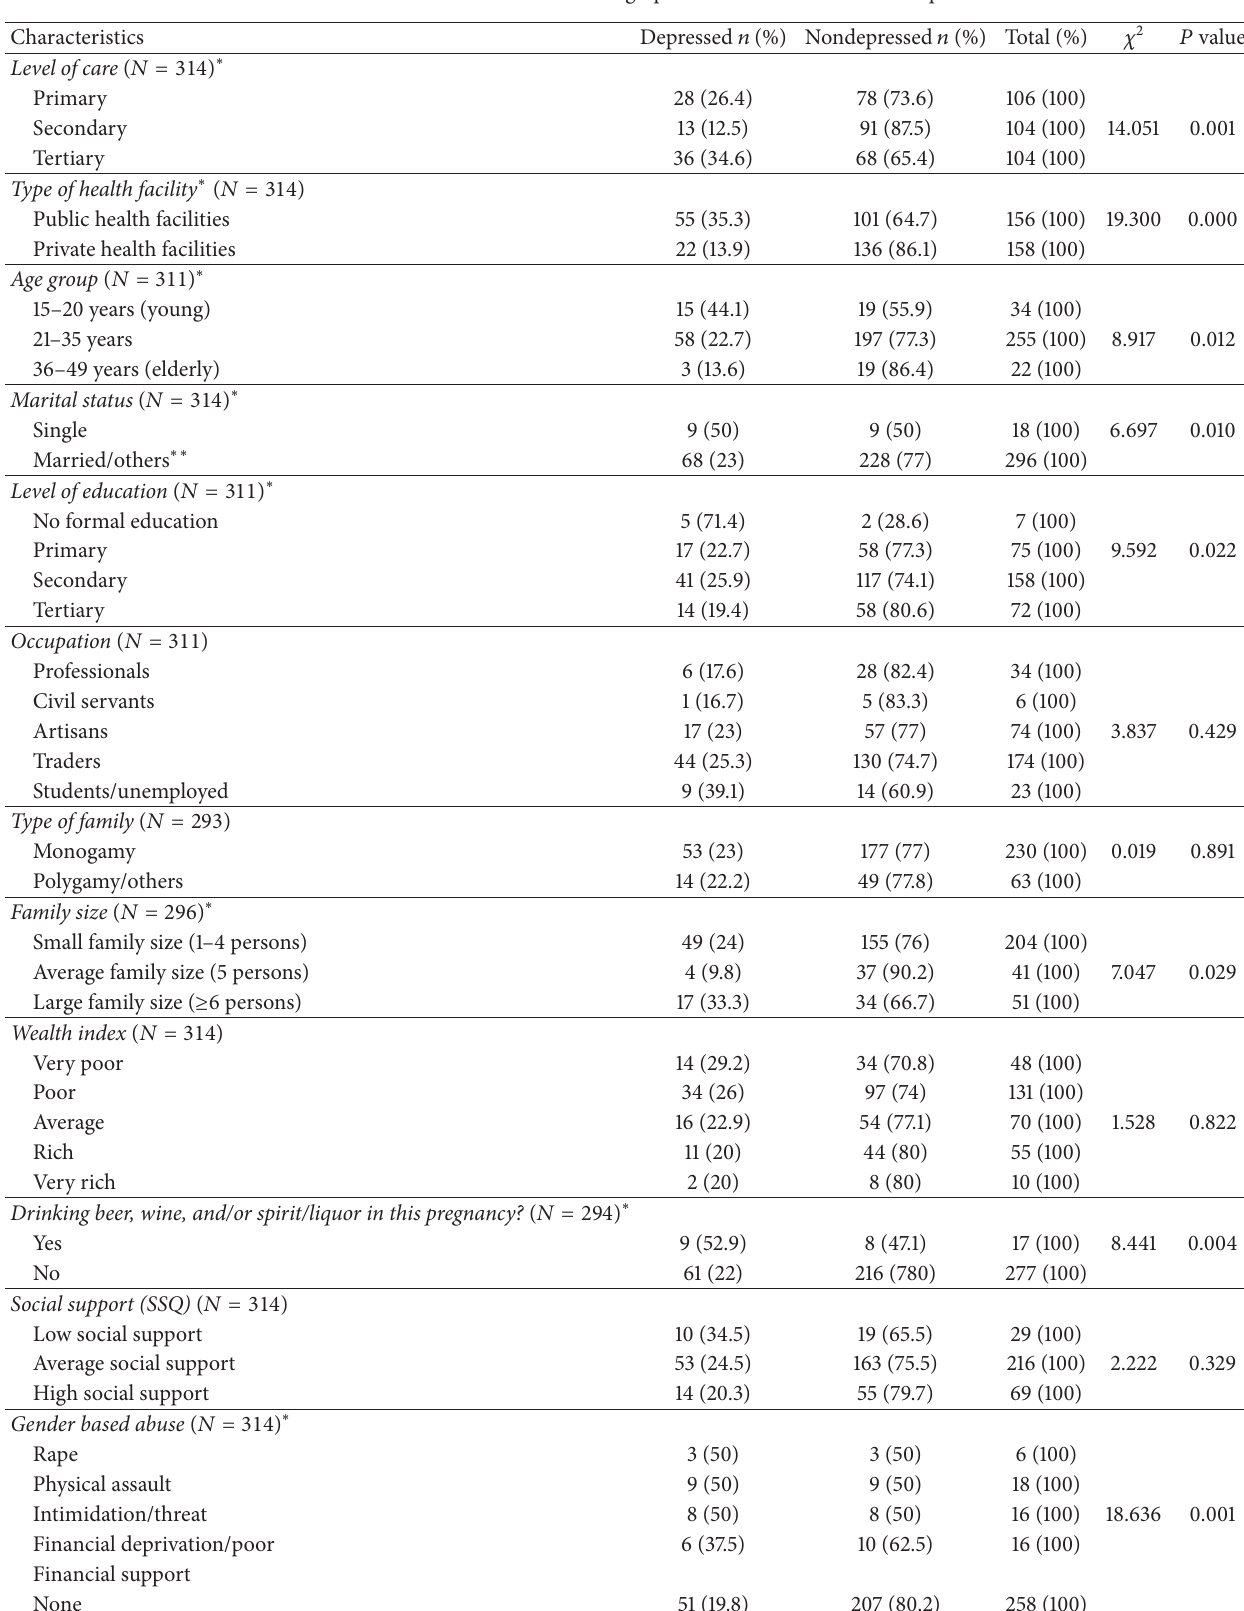
Table 3: Associations between sociodemographic variables and antenatal